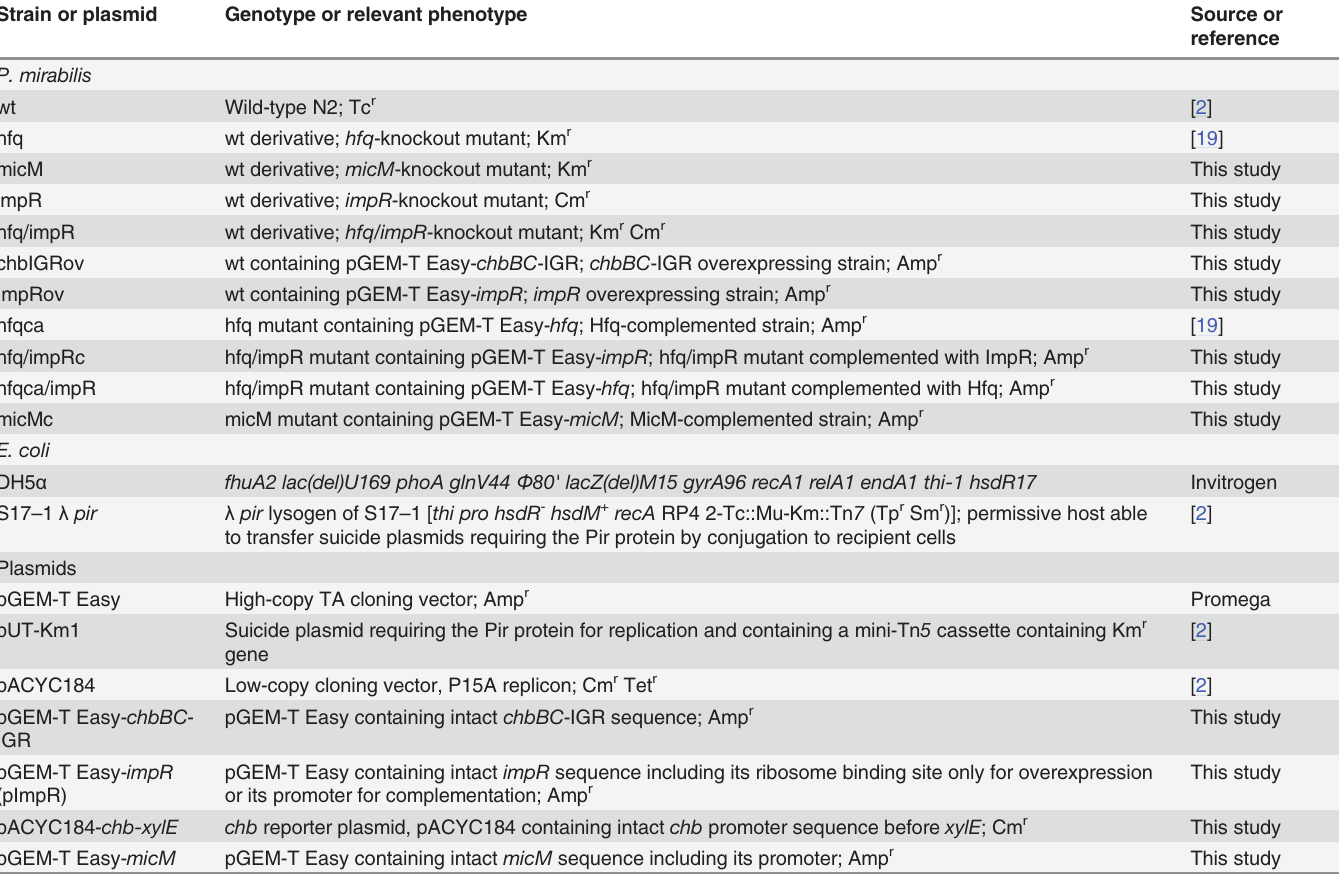
Table 1. Bacterial strains and plasmids used in this study. Strain or plasmid Genotype or relevant phenotype Source or